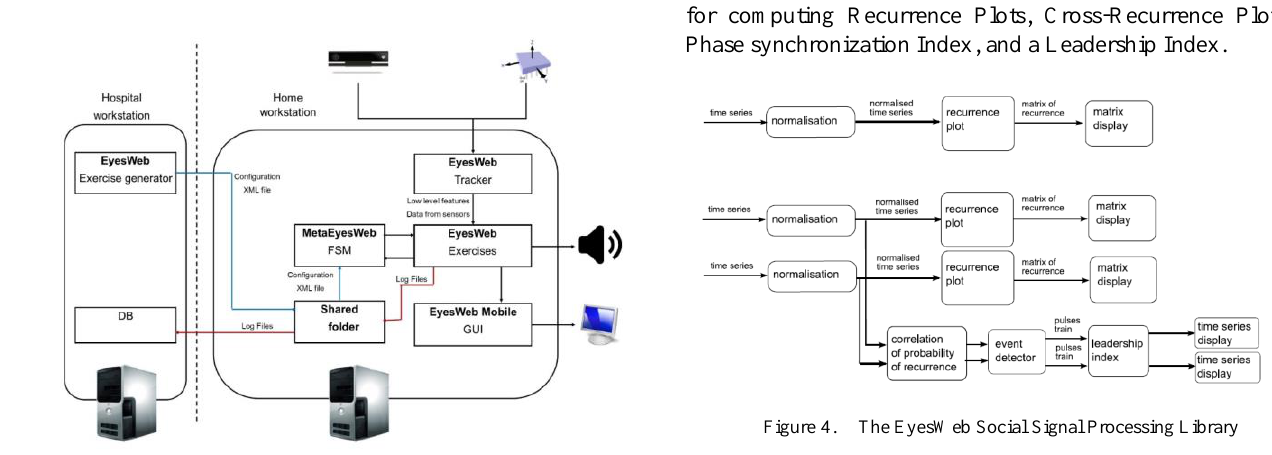
Figure 4. The EyesWeb Social Signal Processing Library